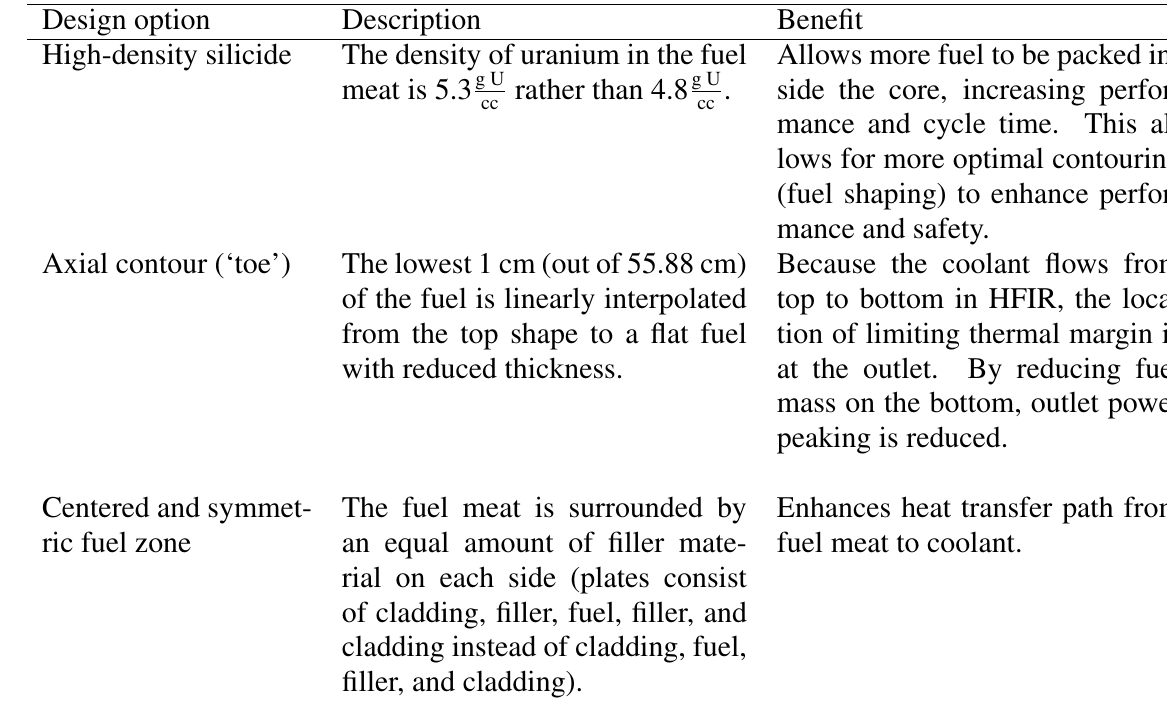
TABLE I. Fuel design options and